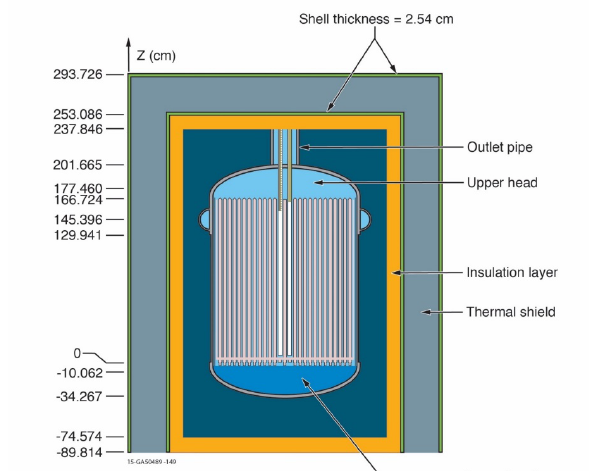
Figure 3. Vertical Cross Section of the MSRE Model at 911 K. Credit: David R. Sharp, Idaho National